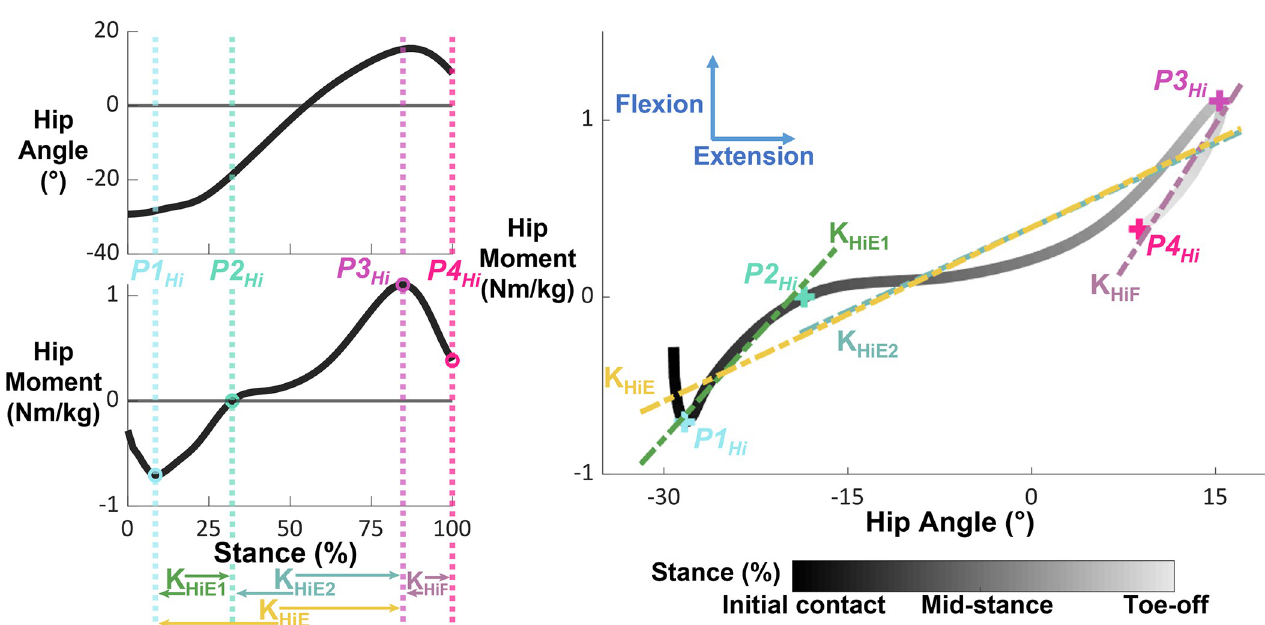
Fig 3. Hip angle, moment, and moment-angle relationships during stance phase overlaid with points of interest and phases of quasi-stiffness. The smaller subplots on the left show hip angle and moment during stance phase. The dashed vertical lines represent the timings of each point of interest, while the open circles identify the point of interest itself. The phases of quasi-stiffness are identified at the bottom of these plots, with the arrows indicating their onset and termination. The large, right figure shows the moment-angle relationship with the quasi-stiffness overlayed as dashed lines and the points of interests as “+”. Data for visualization were normalized to 60 data points and averaged across all participants walking in normal gravity at 1.6 m/s. Direction of internal joint moment and joint angle are indicated with arrows on the rightmost plot.